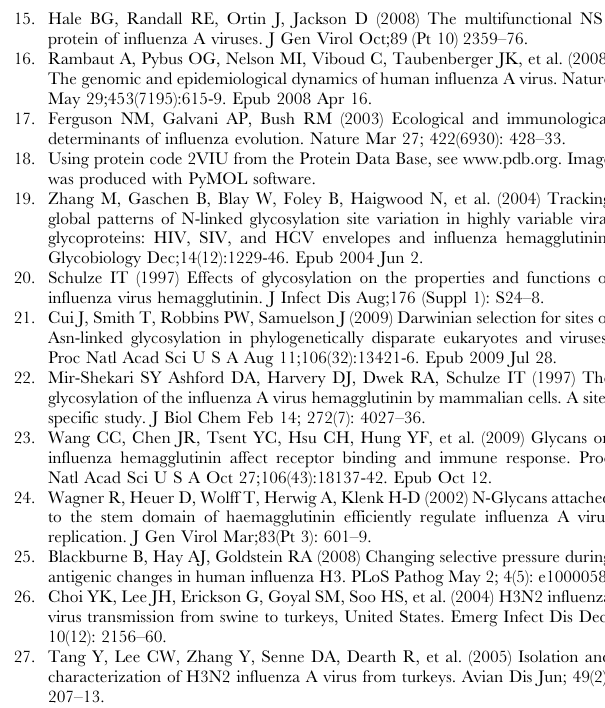
Figure S1 Number of HA1 amino acid sequences available from GenBank, as a function of time. Figure S2 The probability distribution of charge states occupied by each amino acid position in the HA1 sequence, in the year 2000. The majority of points lie along the edges, indicating a strong dominance of the corresponding charge state at those sites. Figure S3 HA charge distribution in avian hosts, for H3 viruses. The figure above was obtained using all 364 full-length avian H3 virus sequences in the NIAID influenza database [14].